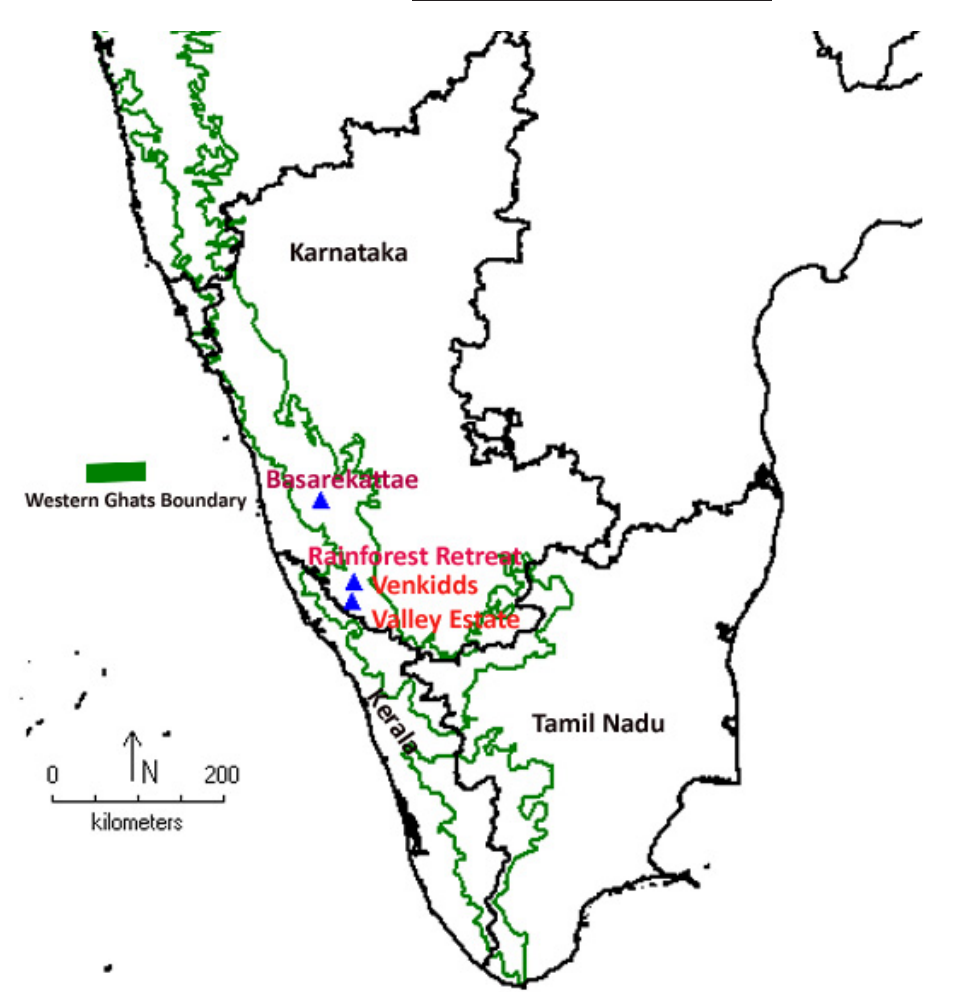
Figure 1. Distribution details of Ichthyophis kodaguensis in Western